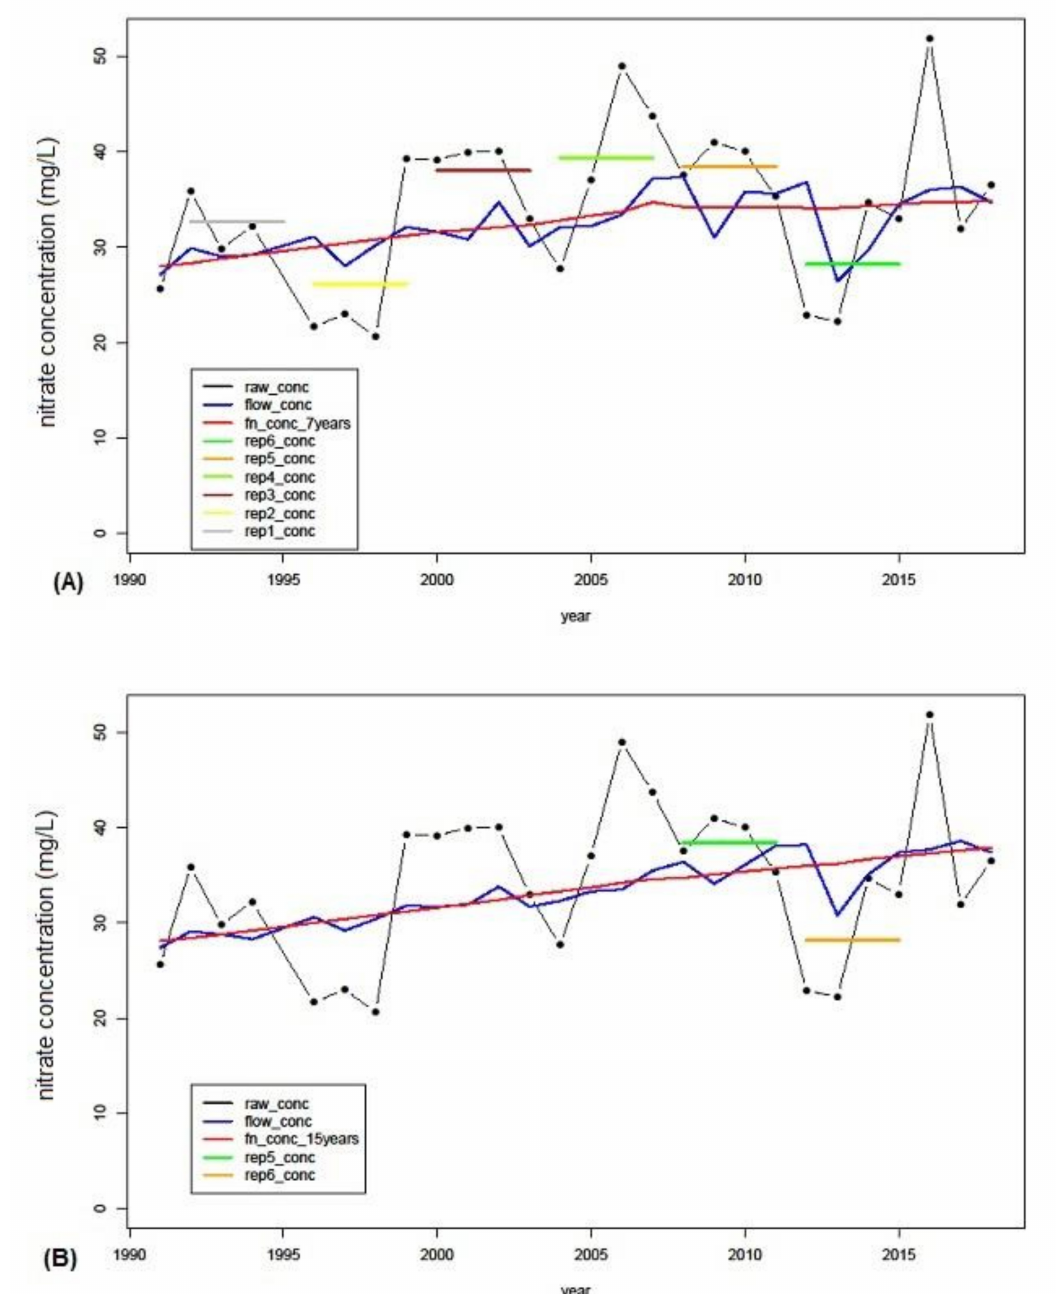
Figure 7. ( A ) The red line is the estimated nitrate concentration (flow-normalized, for random variation of flow (fn_conc_7years)) for station 5,167,000, along with the average values calculated for all reporting periods (every four years, starting from 1991, rep1_conc). ( B ) The red line is the estimated nitrate concentration (flow-normalized, with no random and systematic variations (fn_conc_15years)) for station 5,167,000, along with the predicted calculated average nitrate concentrations for the last two reporting periods (rep5, 2008–2011 and rep6, 2012–2015) ( B ). In both ( A ) and ( B ): the black dotted line represents the annual concentration obtained as a simple mean of the measured concentration (raw_conc, WQWD154), and the blue line is the mean nitrate concentration obtained using a flow-weighted concentration (flow_conc,